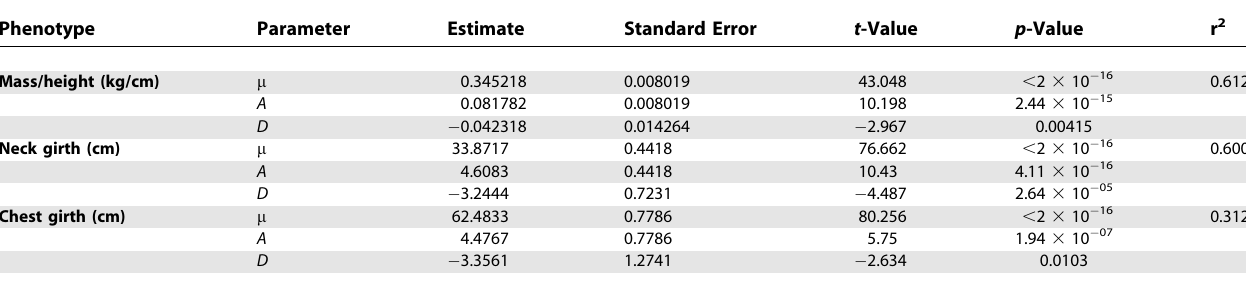
Table 1. Summary of Least-Squares Regression of Musculature Phenotype on mh